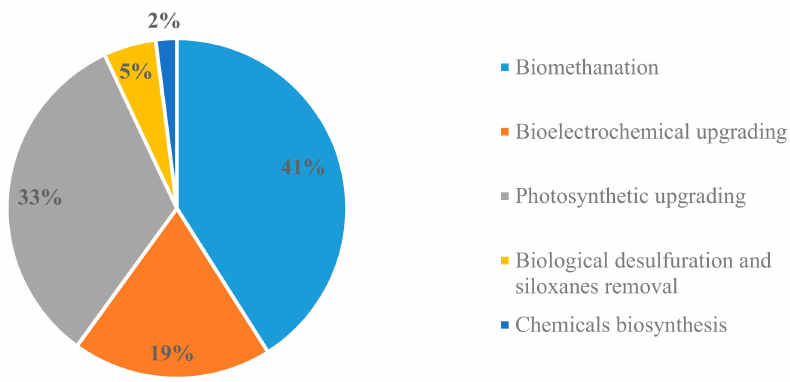
Figure 4. Biological upgrading by technology (number of articles,